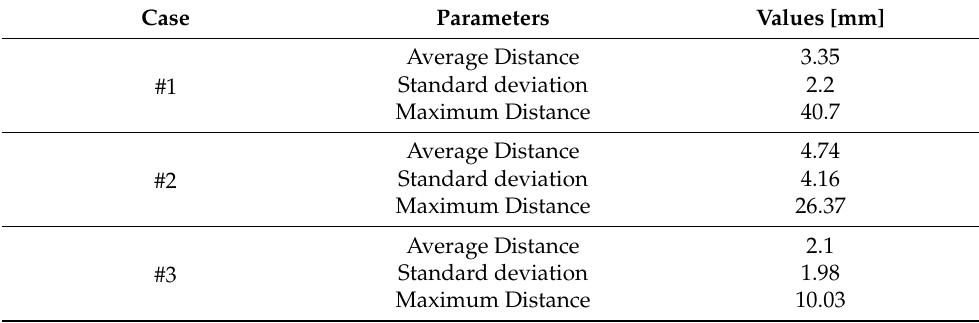
Table 1. Results of the validation.